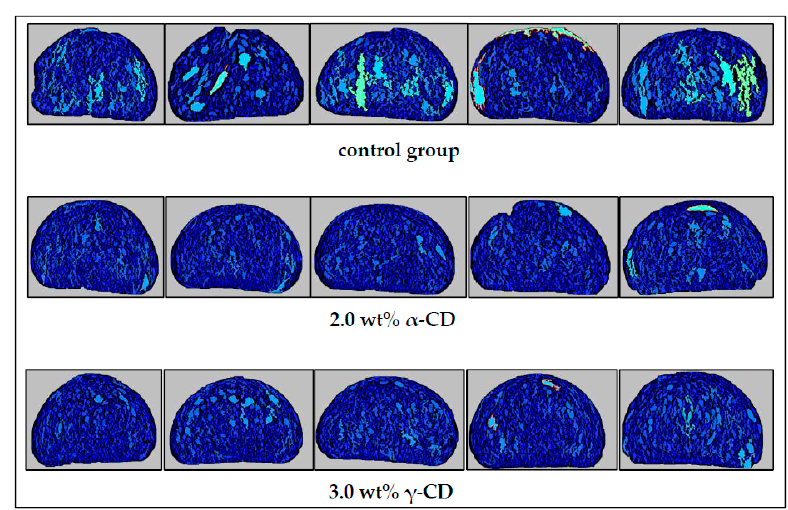
Figure 5. Slice structure of the prebaked bread samples in the control group, 2.0 wt% α -CD group, and 3.0 wt% γ -CD group (frozen for three days). Each group was tested six times in parallel with three repetitions. Three images were taken for comparison.